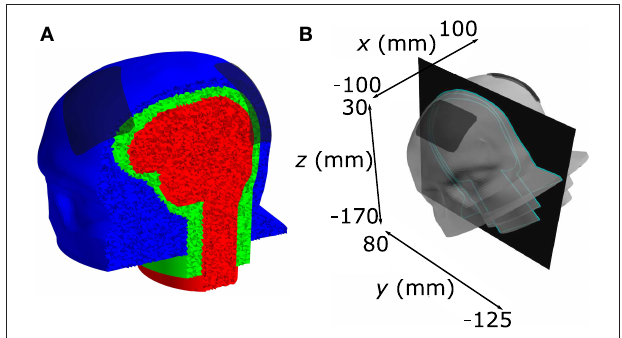
FIGURE 6 | (A) Tetrahedral FEM mesh consisting of intra-cranial volume (red), skull (green), and scalp (blue) compartments. The electrodes are illustrated in transparent gray. (B) Model positioning in the MRI coordinate system. The plane between the electrodes corresponds to the slice in Figures 8 , 9 .